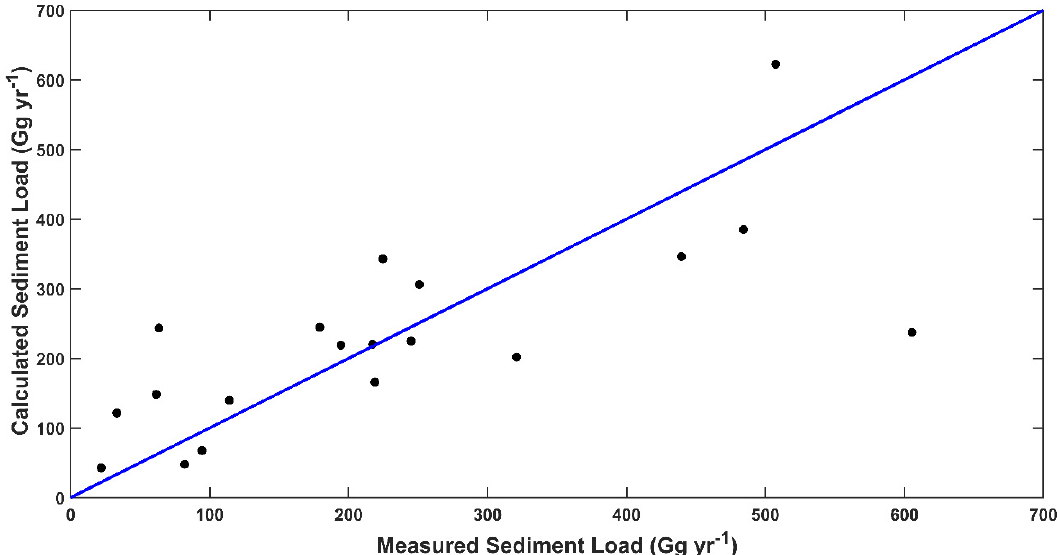
Figure 12. Comparison between the measured and calculated annual sediment load for the Tonusco river basin.